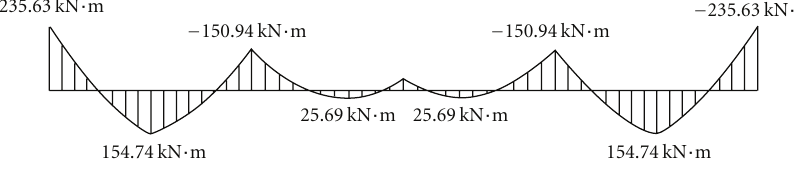
Figure 10: Bending moment diagram for the third example.